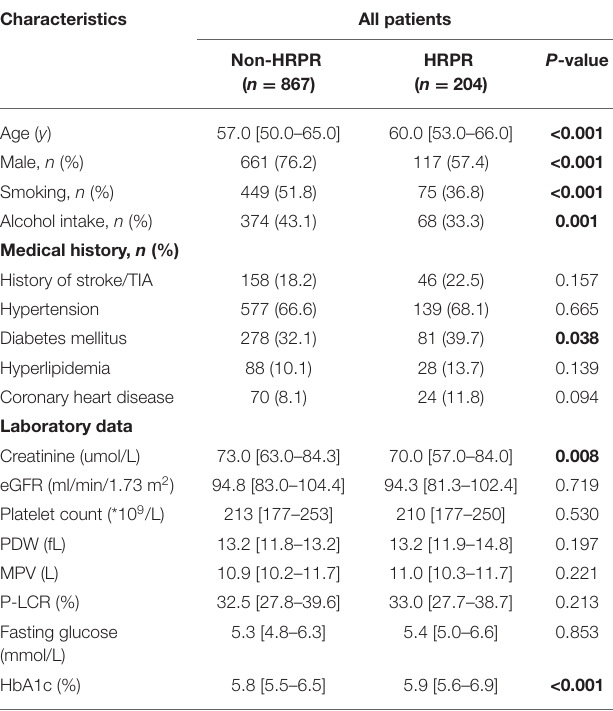
TABLE 3 | Risk factors for clopidogrel high residual on-treatment platelet reactivity (clopidogrel HRPR) in all patients.